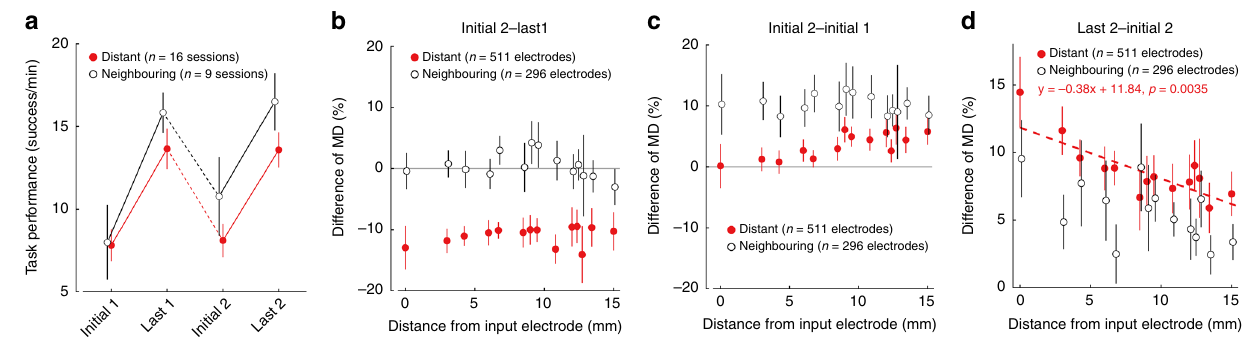
Fig. 7 Population data of cortical adaptation to ACMC. a Task performance in the initial and last phases of two consecutive ACMC sessions with different input electrodes in Monkey TE and M (Distant electrode [red], n = 16 sessions; Neighbouring electrode [black], n = 9 sessions). Task performance in Last 1 and Last 2 was signi fi cantly higher than in Initial 1 and Initial 2, while task performance after a shift to a neighbouring electrode was signi fi cantly higher than after a shift to a distant electrode ( P < 10 − 5 by two-way ANOVA with Bonferroni ’ s correction for post hoc multiple comparisons). b The relationship between the change in MD (Initial 2 – Last 1) and distance from the input electrode. MD was signi fi cantly reduced when the input electrode was shifted to distant sites and unchanged when it was shifted to neighbouring sites. MD changes were not affected by distance from the input electrode. Two-way ANOVA; [Area] F (1) = 98.68, P = 5.63 × 10 − 22 . [Distance] F (13) = 0.45, P = 0.95, not signi fi cant. Post hoc multiple comparisons with Bonferroni ’ s correction; P Distant vs Neighbouring = 5.63 × 10 − 22 . c The relationship between the difference of MD (Initial 2 – Initial 1) and distance from the input electrode. Difference of MD (Initial 2 – Initial 1) were signi fi cantly higher when the input electrode was moved to neighbouring sites compared to when it was moved to distant sites. Two-way ANOVA; [Area] F (1) = 34.65, P = 5.87 × 10 − 9 . Post hoc multiple comparisons with Bonferroni ’ s correction; P Distant vs Neighbouring = 5.87 × 10 − 9 . d The relationship between difference of MD (Last 2 – Initial 2) and distance from the input electrode. A signi fi cant correlation between distance from the input electrode and difference of MD was found only for the distant electrodes, shown by the red dotted line (Pearson correlation coef fi cient, R = − 0.129, P = 3.49 × 10 − 3 ). Data represent means and standard errors. Data for b – d were obtained from Monkey M and TE (Distant (red): n = 511 electrodes from 16 sessions; Neighbouring (black): n = 296 electrodes from nine sessions). Detailed statistical results for a – d are shown in